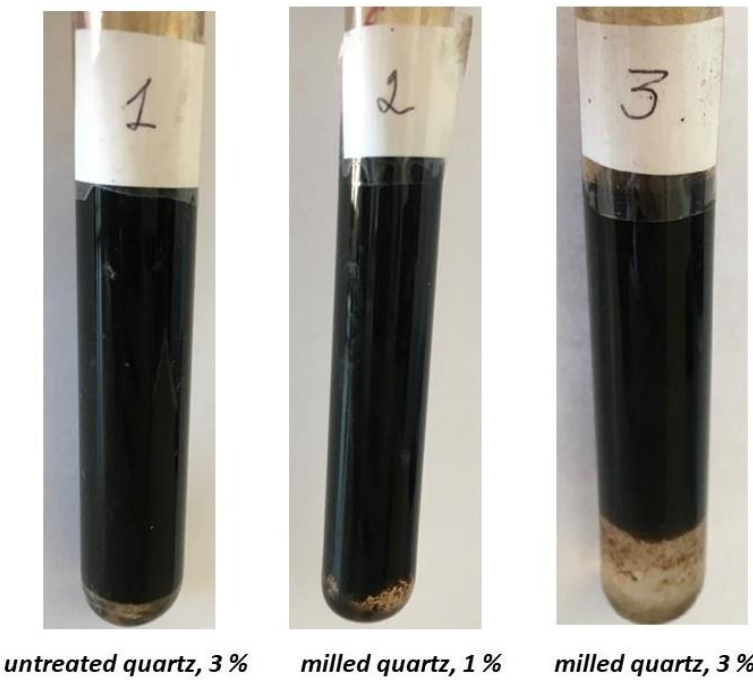
Figure 9. Samples of the w/o emulsions after settling for 140 min in the presence of the original and freshly milled quartz particles.